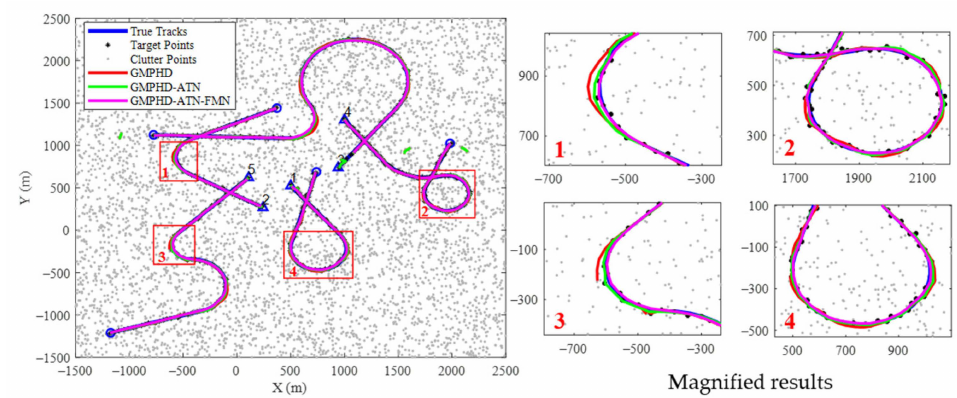
Figure 11. Tracking results of a single simulation.